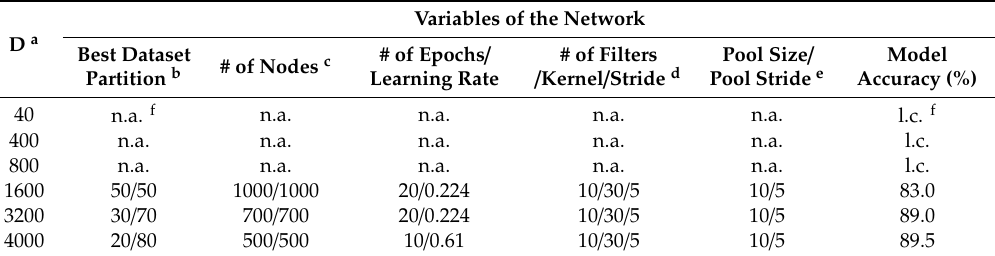
Table 2. Convolutional neural network (CNN): best results.